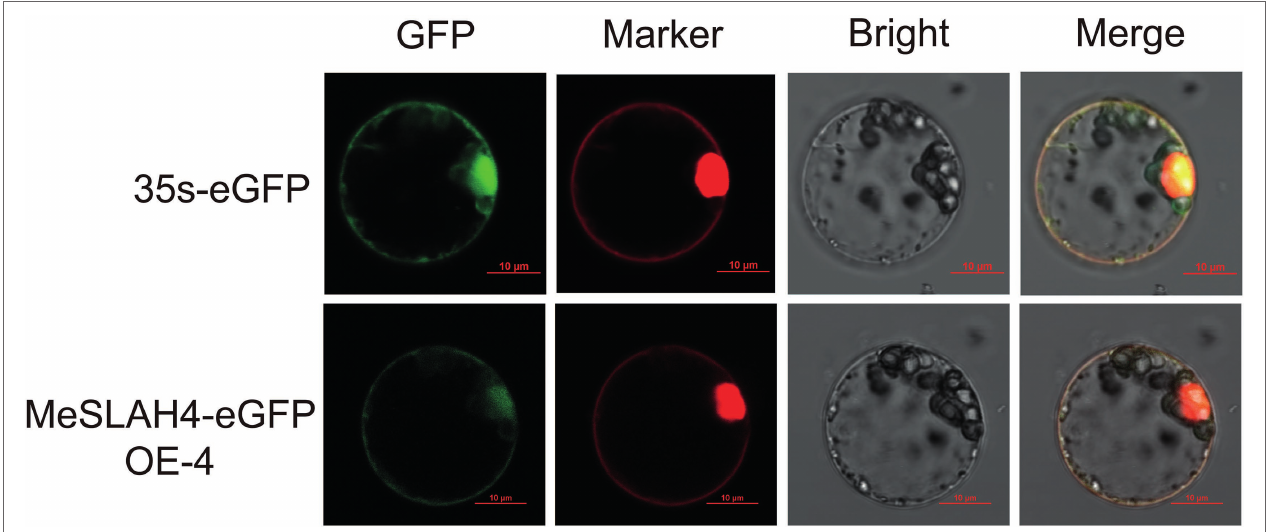
FIGURE 3 | Subcellular location of MeSLAH4 proteins. MeSLAH4-eGFP or 35 s-eGFP driven by the 35S promoter were transiently expressed in rice mesophyll protoplasts. Green signals indicate eGFP and red signals represent mCherry fluorescence. The merged images include the green fluorescence channel (first panels) and the chloroplast autofluorescence channel (second panels). The corresponding bright field images are shown on the right. Bar = 10 μ